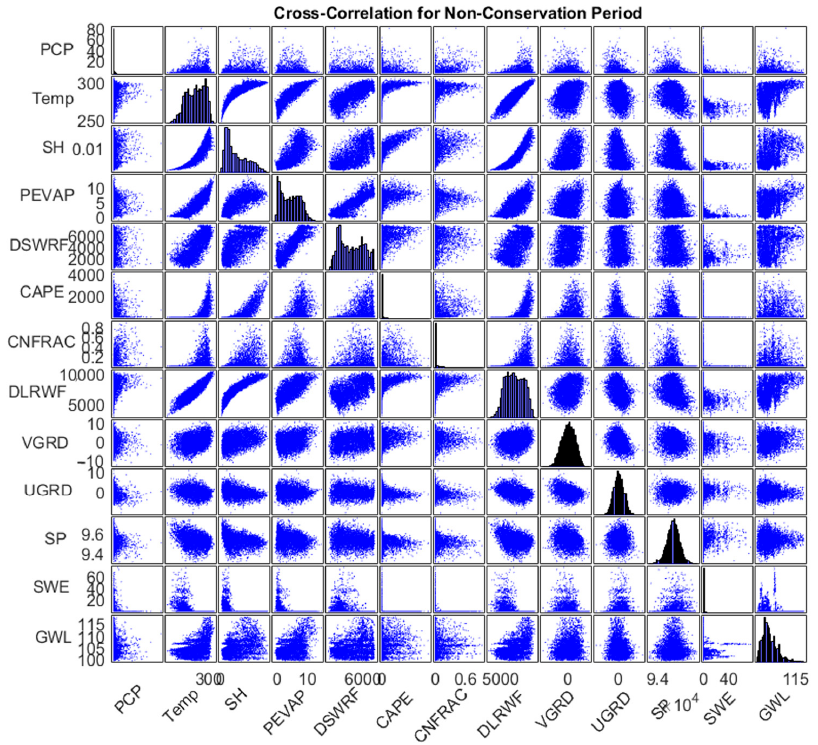
Figure A3. Cross ‐ correlation pair plot for all 13 predictive variables over the non ‐ conservation pe ‐ Figure A3. Cross-correlation pair plot for all 13 predictive variables over the non-conservation period riod (1990–2004).